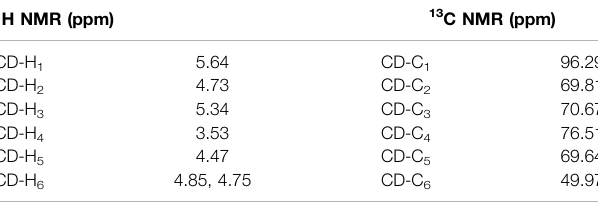
TABLE 1 | Chemical shifts of 1 H and 13 C NMR of β -CD unit in conjugate 23